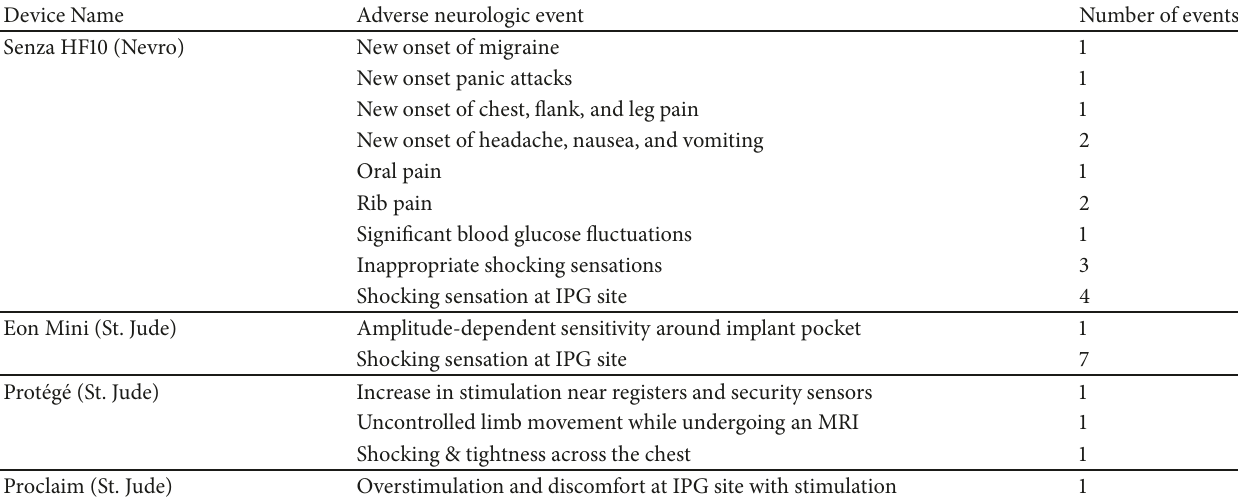
Table 1: Neurological complications noted in the FDA MAUDE database according to device manufacturer and number of events